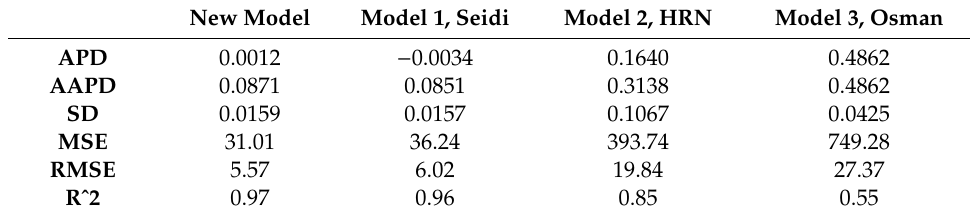
Table 10. A comparison of six di ff erent measures of accuracy corresponding to di ff erent models using production data set of the 144 / 64 inch choke size.